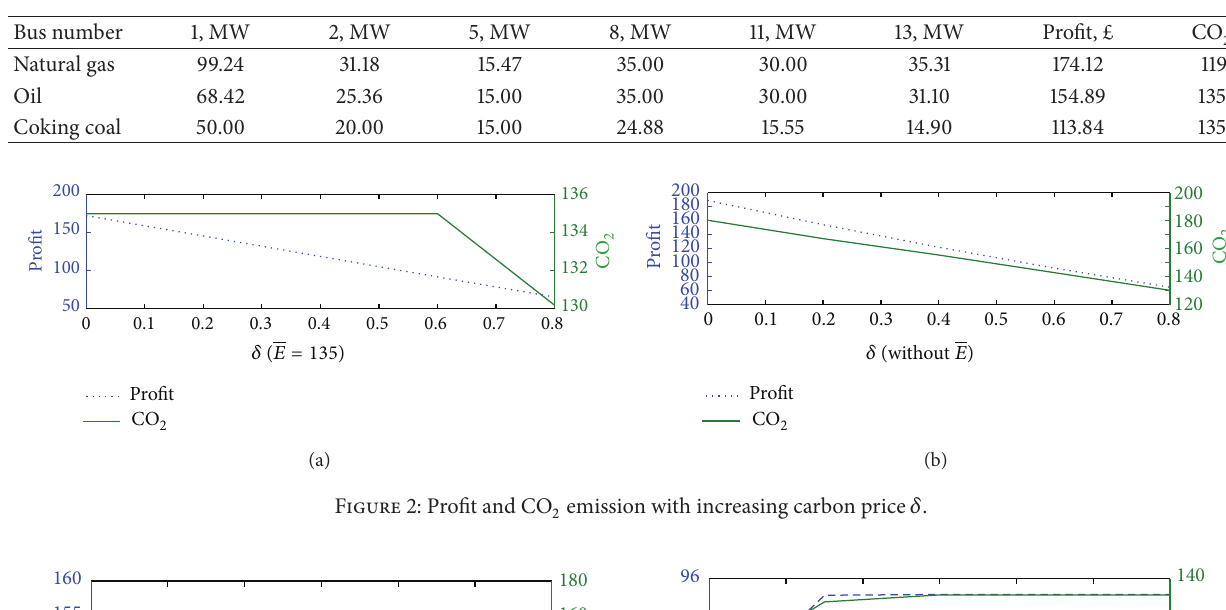
Table 4: The result of using one kind of fuel ( 𝛿 = 0.2 £/ton, 𝐸 = 135.0 ton).